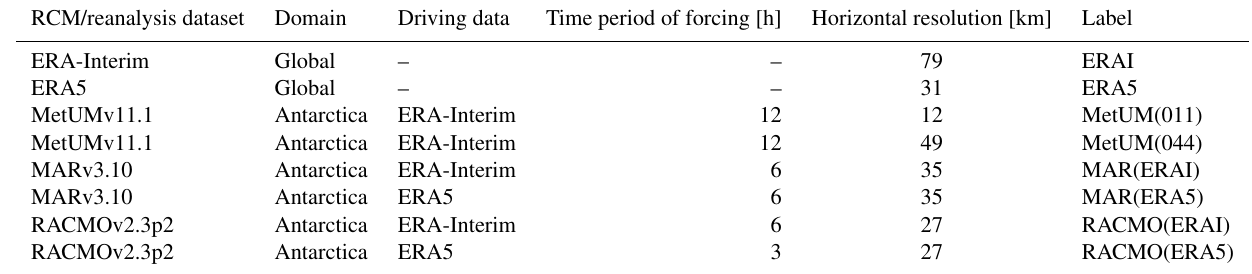
Table 1. The two reanalysis datasets and six RCM simulation outputs compared in the paper. The label with which each simulation is referred to in the paper is